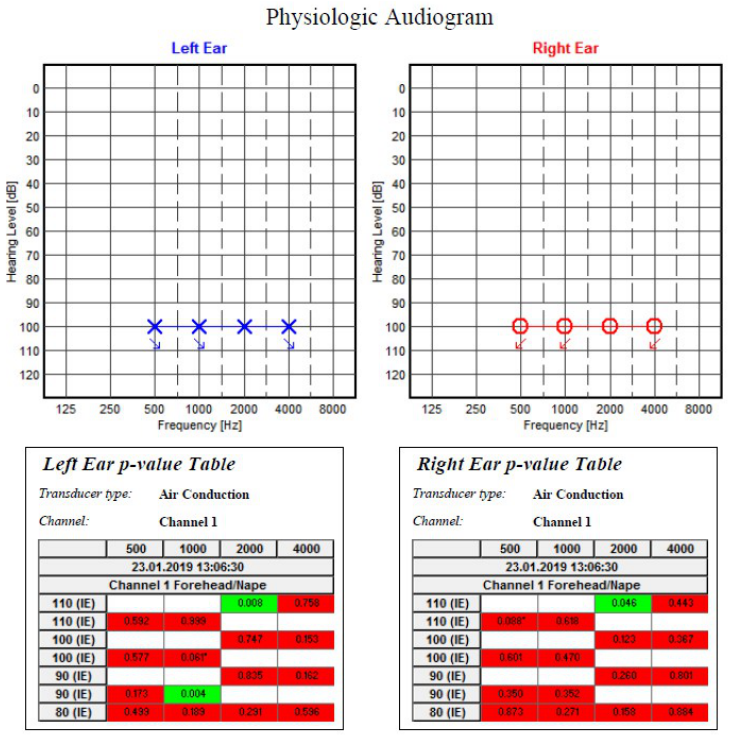
Figure 4. Auditory Evoked Potentials results for Case 2. No evoked response upon maximal stimulation (95 dB nHL) bilaterally.